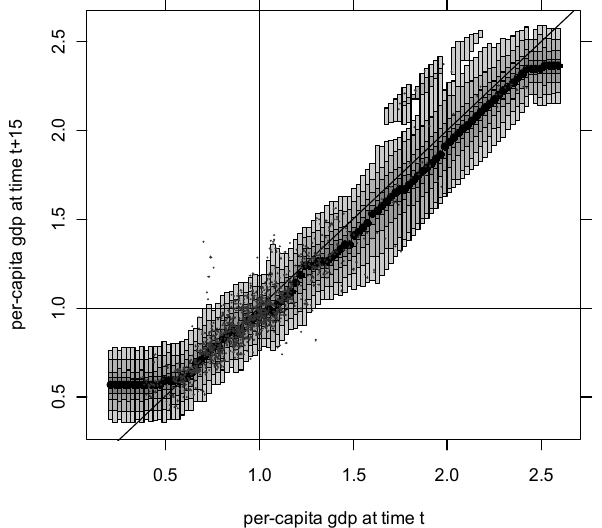
Figure A4 – Intra-Distribution Dynamics of regional per-capita income in Europe. HDR plot of conditional density for transitions of 15 years between 1980-2002. Groningen is ex- cluded from the sample. Estimates are based on a kernel density estimator with a variable bandwidth in the x direction (span = 0.05), a fixed bandwidth in the y direction (b = 0.111) and a mean function specified by a lowess smoother (span =